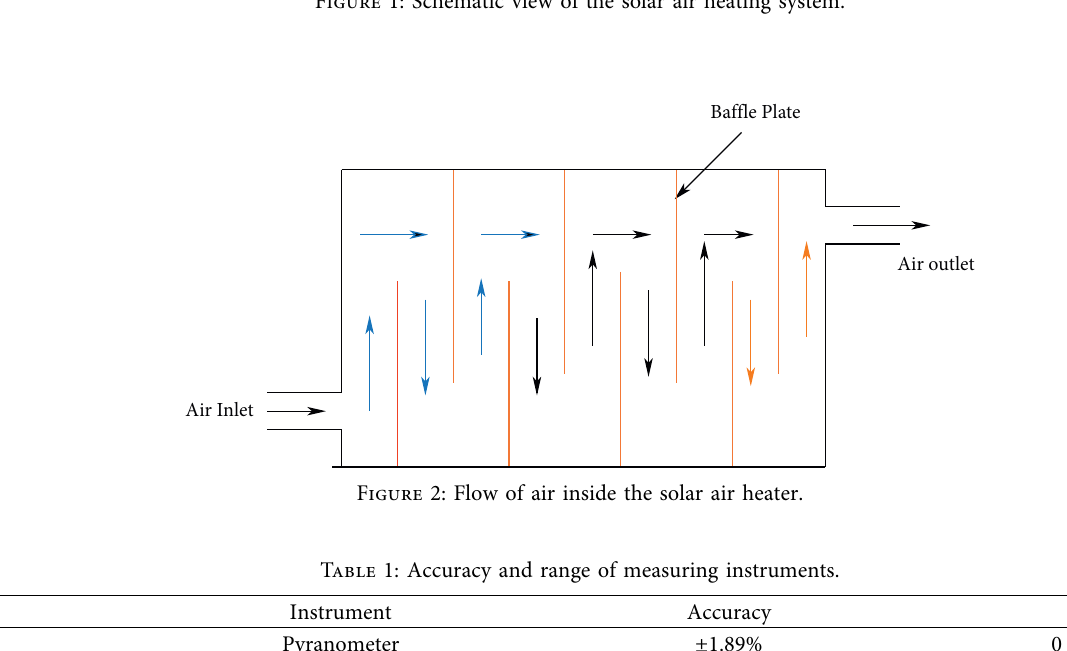
Figure 1: Schematic view of the solar air heating system.